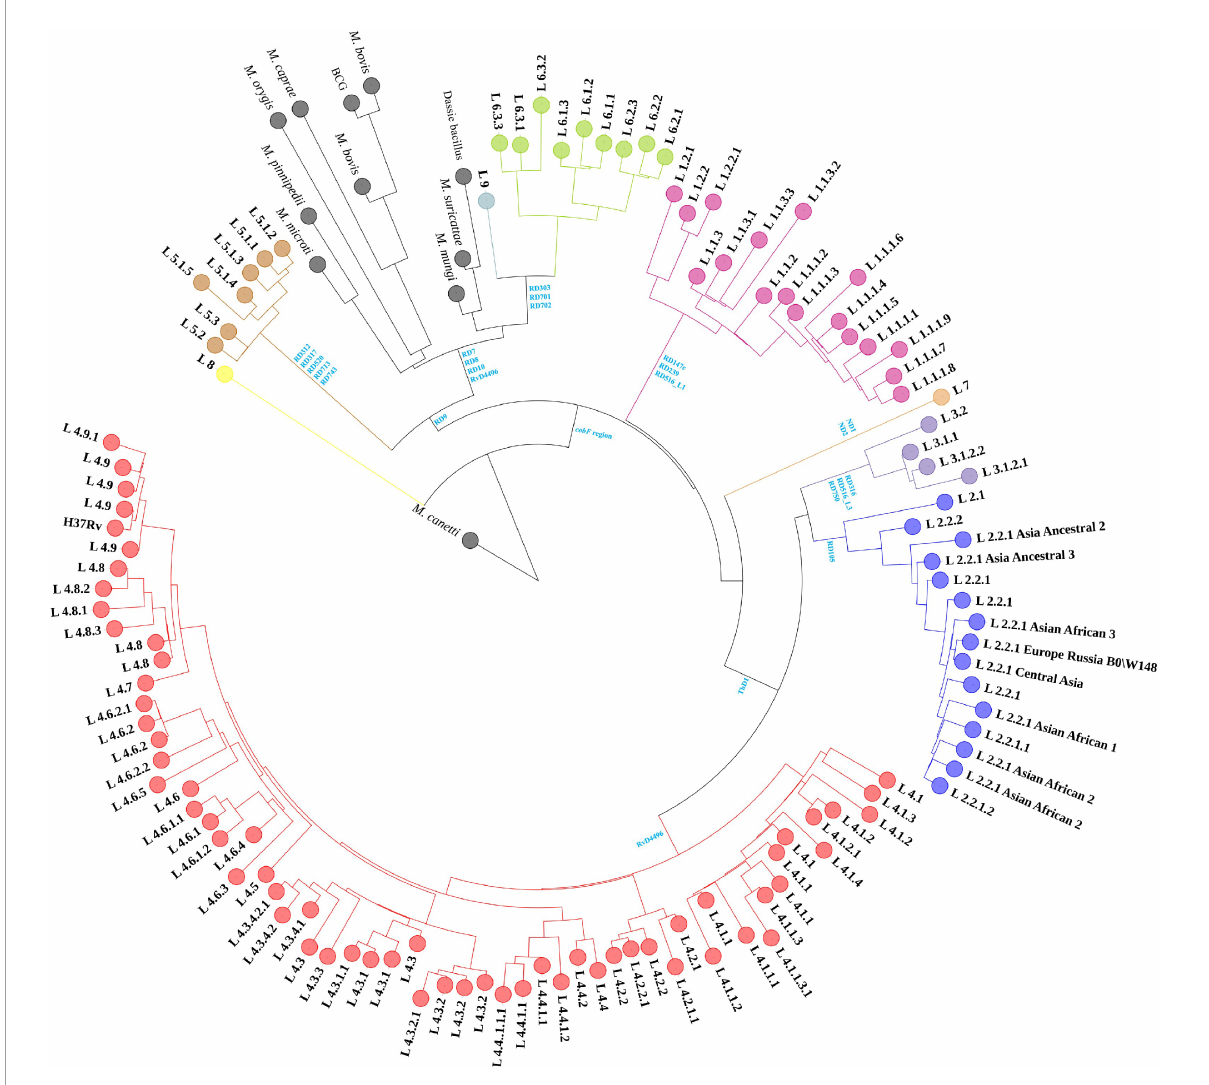
FIGURE1 Maximum-likelihood phylogenetic tree of MTBC strains in sampled dataset. Clades were shrunk by lineage or sub-lineage, and the size of external nodes did not represent the number of strains.